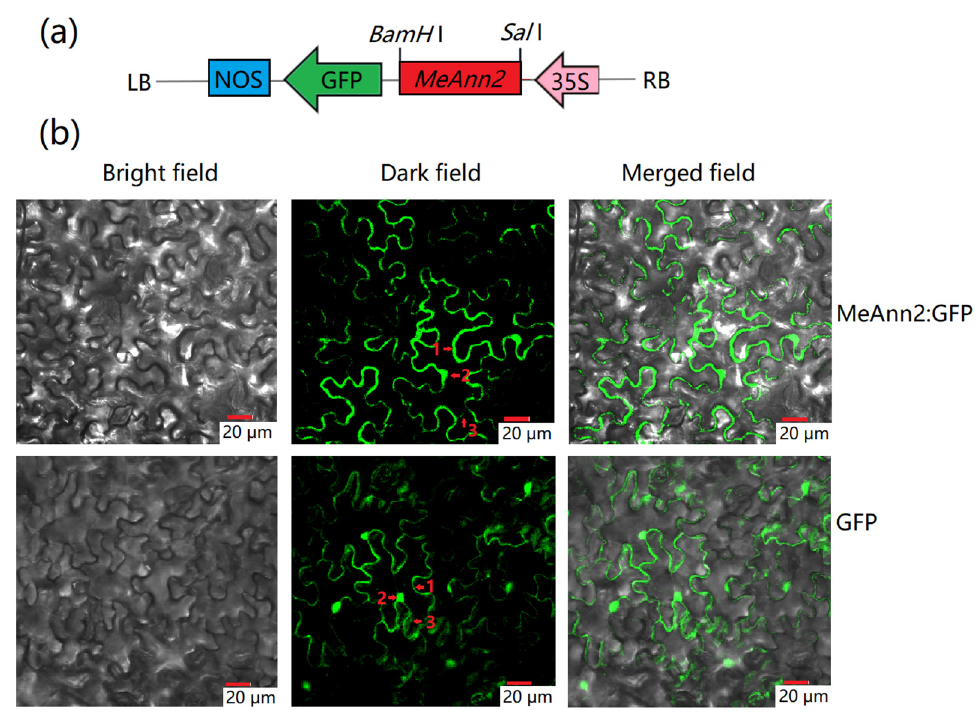
Figure 2. Subcellular localization analysis of the MeAnn2 protein in tobacco leaf cells. ( a ) Schematic diagram of pCAMBIA1300-35S- MeAnn2:GFP vector construction; LB indicates the left border and RB indicates the right border of the pCAMBIA1300 vector. ( b ) The fluorescence signal detected in transfected cells. From left to right, the picture is of a bright field, dark field, and merged field of light and shade. The scale is 20 µ m. The red arrows and red number point out the localization of MeAnn2. 1, cell membrane; 2, nucleus; and 3, cytoplasm.